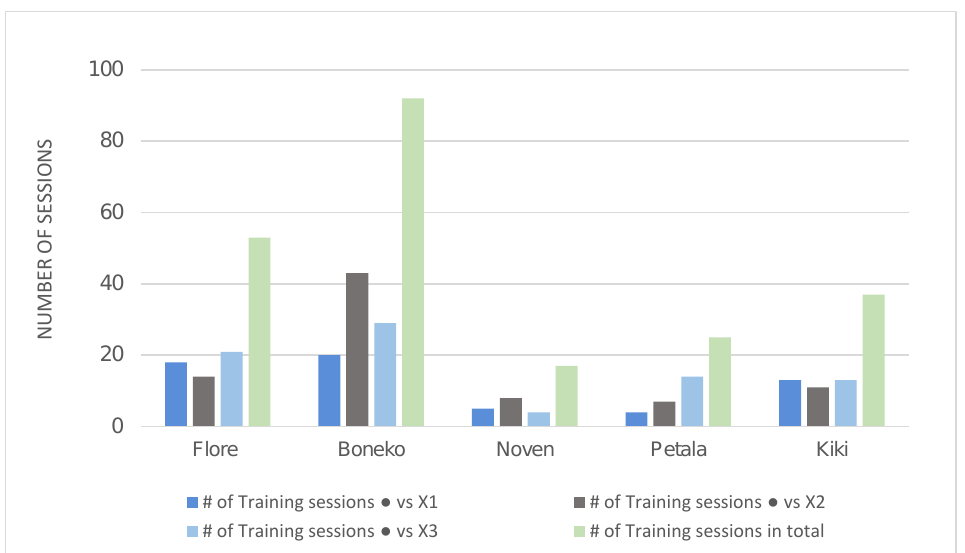
Figure 4. The number of discrimination learning sessions for each horse. Training proceeded in three stages of changing the size of the S- (X1: 5 cm, X2: 8 cm, and X3: 15 cm, see Methods 2-4-3). The two sessions with 100% accuracy were included in the total number of sessions. The X -axis shows the horses in order of age (13, 8, 5, 4, and 2 years old). Special aid was given to the disabled horse, Flore, in this preliminary training (see Figure A4 for the raw data).